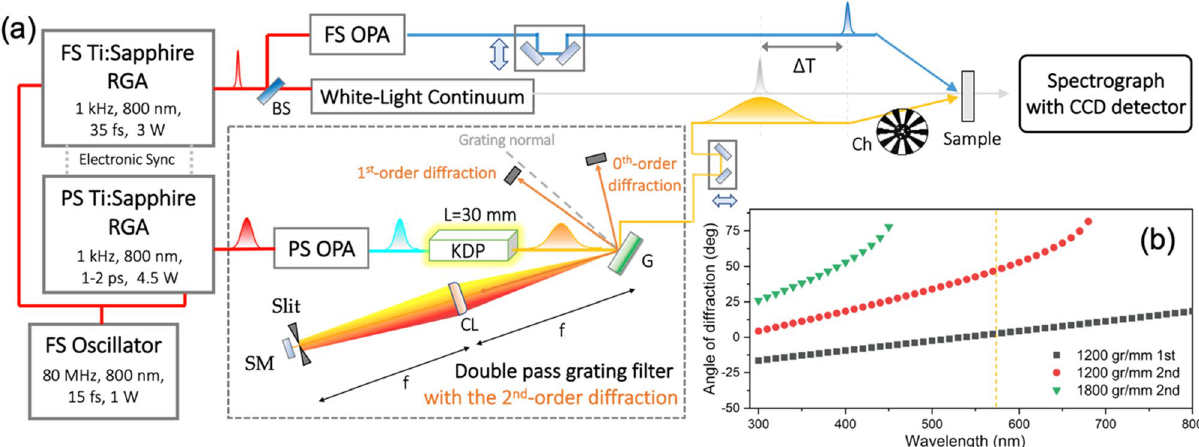
Figure 1. ( a ) The schematic of the synchronized fs and ps Ti:Sapphire RGA laser systems and the optical layout for FSRS using the DPGF employing the 2nd-order diffraction. The laser output from the fs RGA generates the wavelength-tunable actinic pump pulse (blue line) and the white-light continuum Raman-probe pulse (gray line). The DPGF with the 2nd-order diffraction tailors a narrow bandwidth ps Raman-pump pulse (yellow line). All three pulses are focused on the sample while the Raman-probe pulse was detected by the spectrograph coupling CCD detector. BS beam splitter, G grating, CL cylindrical lens, SM silver mirror, Ch optical chopper. ( b ) Angle of the 1st- or 2nd-order diffraction of the grating is shown as a function of the wavelength of input beam with the incidence angle of 40°. The yellow dash line is the wavelength of 575 nm using Raman-pump